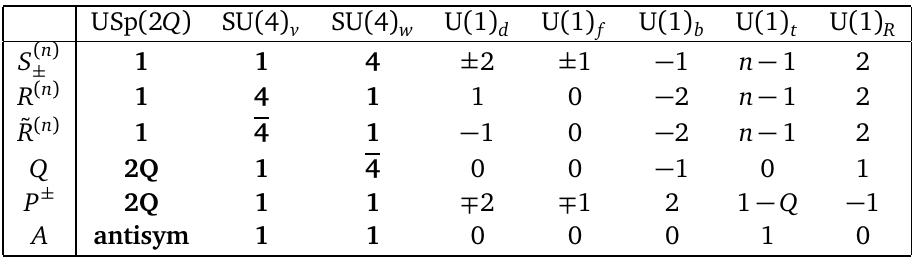
Table 4: The matter contents of the SO ( 14 ) × U ( 1 ) 2 model I and their